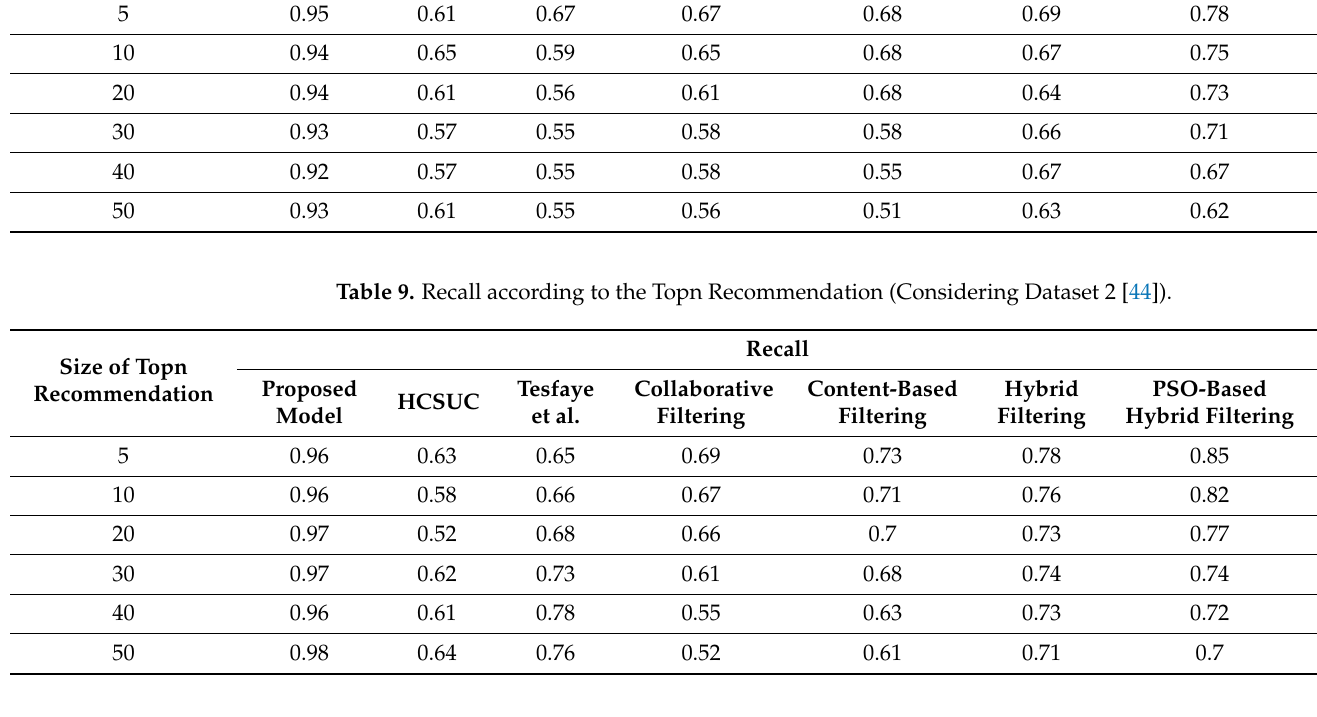
Table 10 represents a comparison of F-Measure values between the proposed model, and different recommendation models considering the testing sets. The experimental results reveal that the proposed model provides an F-Measure of 94.3%. Meanwhile, recommenda- tion models, namely HCSUC and Tesfaye et al., provide an average F-Measure of 59.5% and 61.1%, respectively. Traditional recommendation models, such as collaborative filtering,